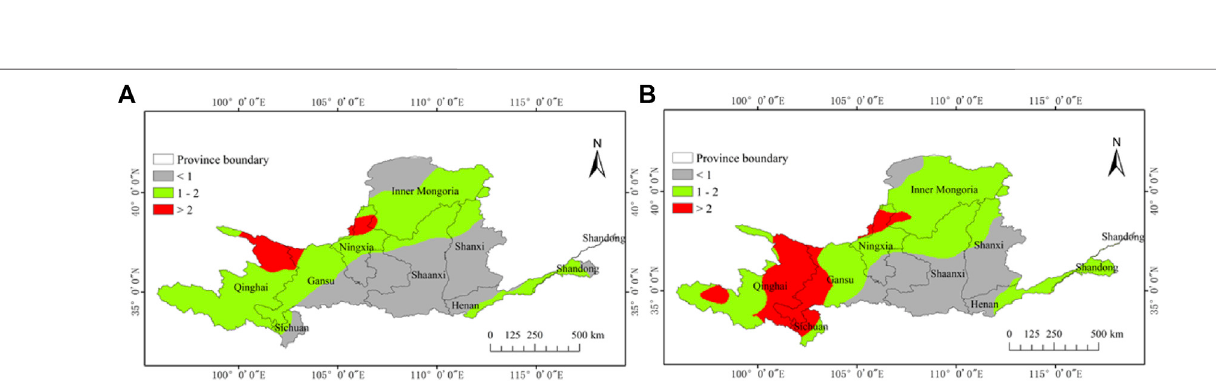
Frontiers in Environmental Science |